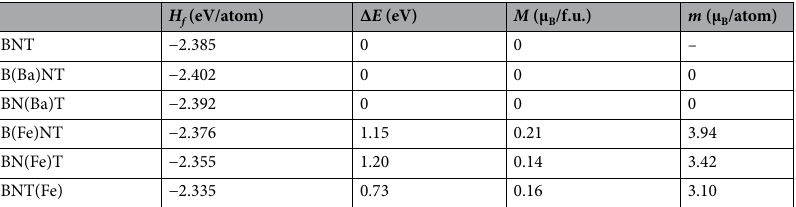
Table 1. The DFT results of the formation energy H f (eV/atom), magnetic energy ΔE (eV/atom), and magnetization M (μ